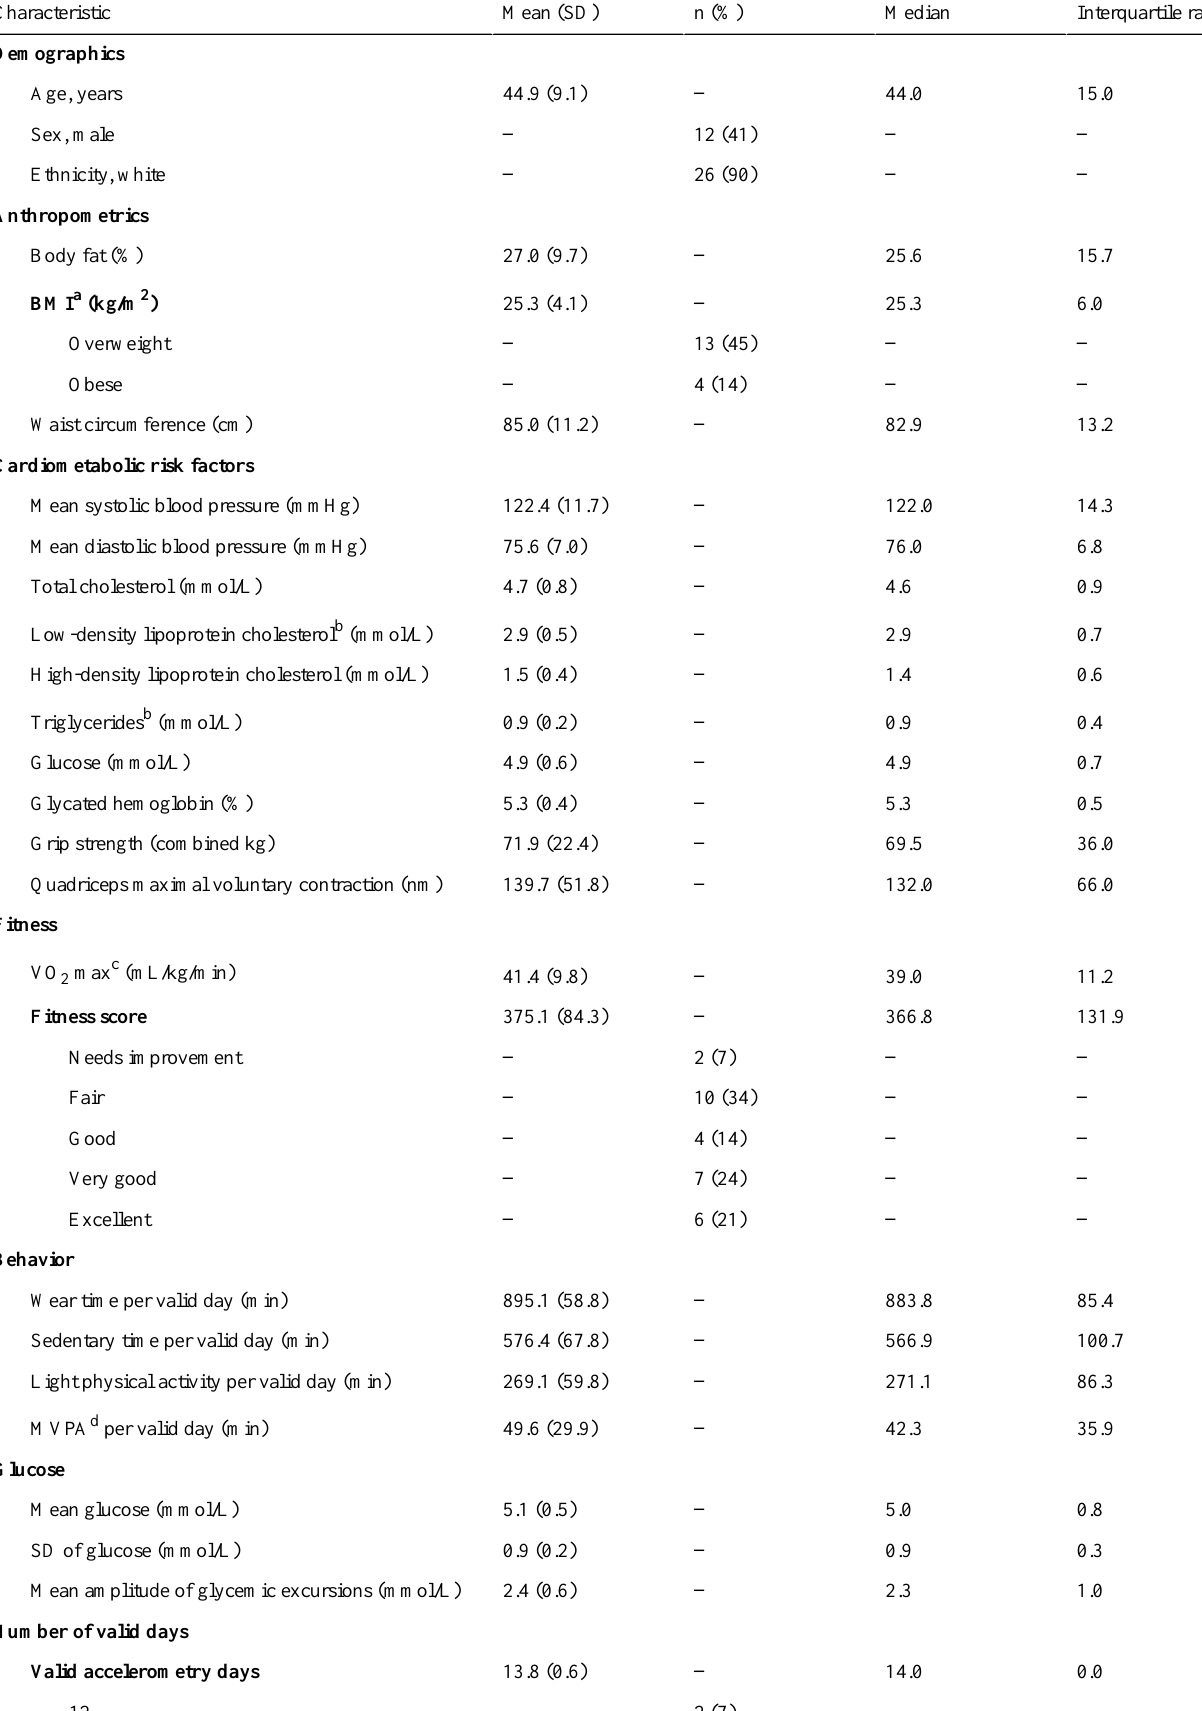
Table 1. Characteristics of the study sample. Valid accelerometry ≥ 600 min; valid glucose ≥ 90% (86/96) of daily data points.